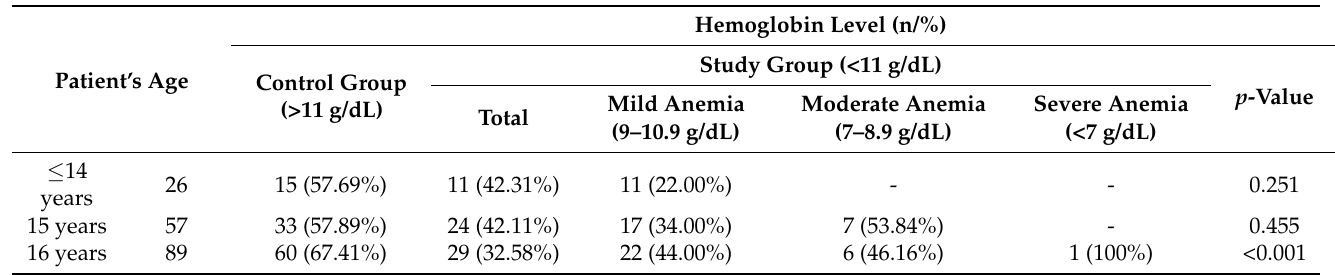
Table 2. Distribution of patients in relation to hemoglobin level and age.